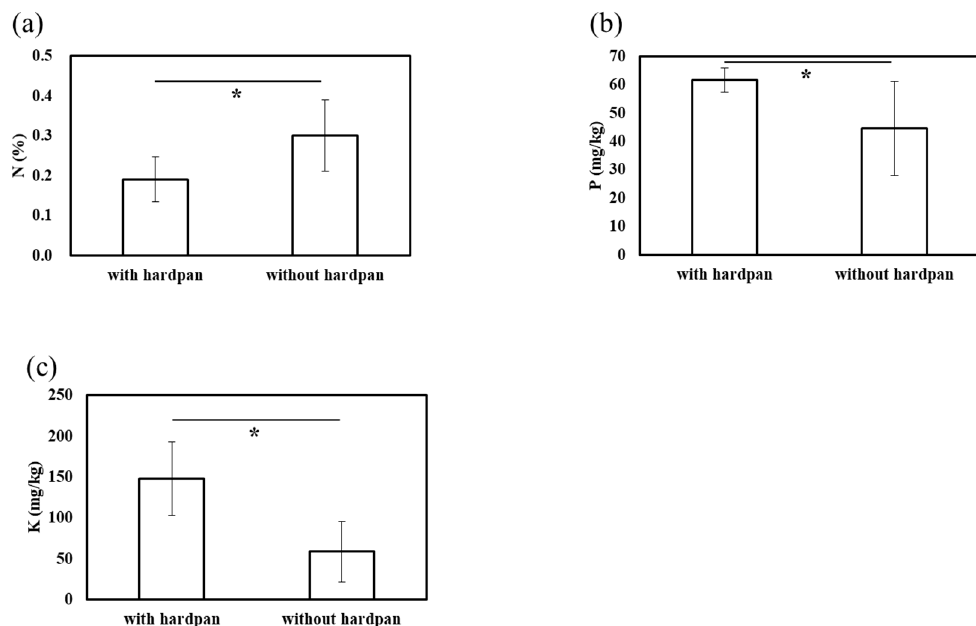
Figure 6. Mineral contents in two groups categorized by hardpan formation. ( a ) Total nitrogen, ( b ) phosphorus, and ( c ) potassium. (*: Mann–Whitney U test, p < 0.05).